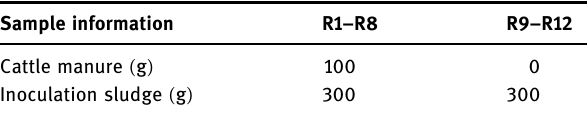
Table 2: Experimental sample feeding information in the anaerobic digestion of cattle manure at sub - mesophilic temperatures Sample